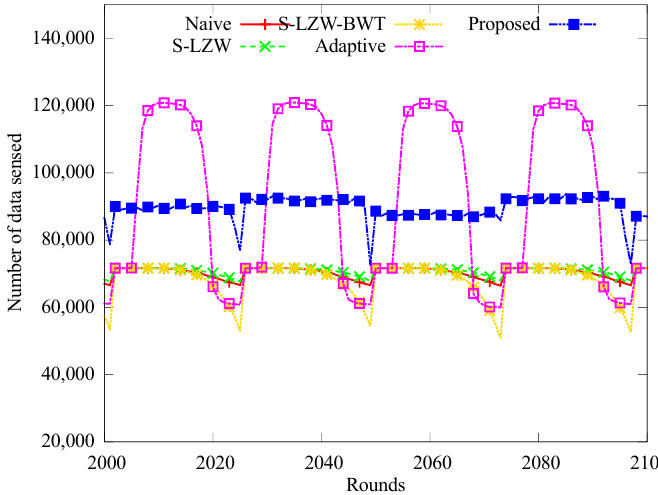
Figure 6. Change in the number of data